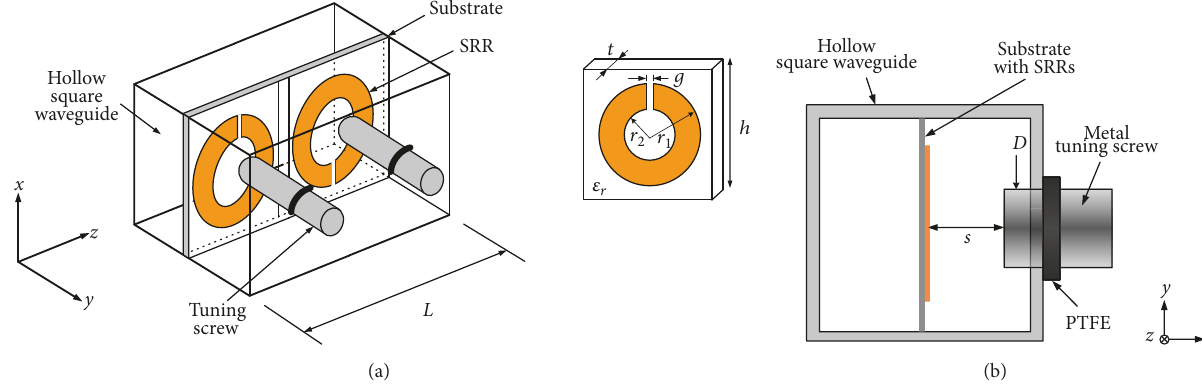
Figure 1: Substrate loaded with an SRR and tuning screw: (a) prospective and SRR, (b) side view.